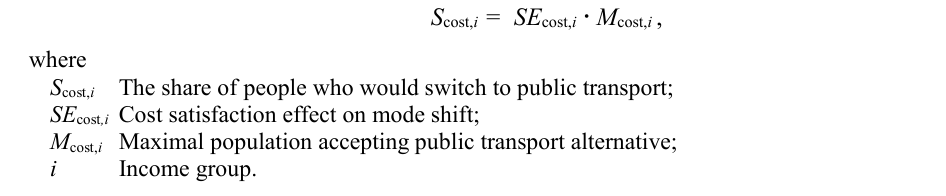
Fig. 5. The cost satisfaction effect on mode shift for different income groups: (a) income up to 750 EUR on a household member; (b) 750–1500 EUR on a household member; (c) more than 1500 EUR on a household member. The share of people who would switch to public transport was calculated using formula